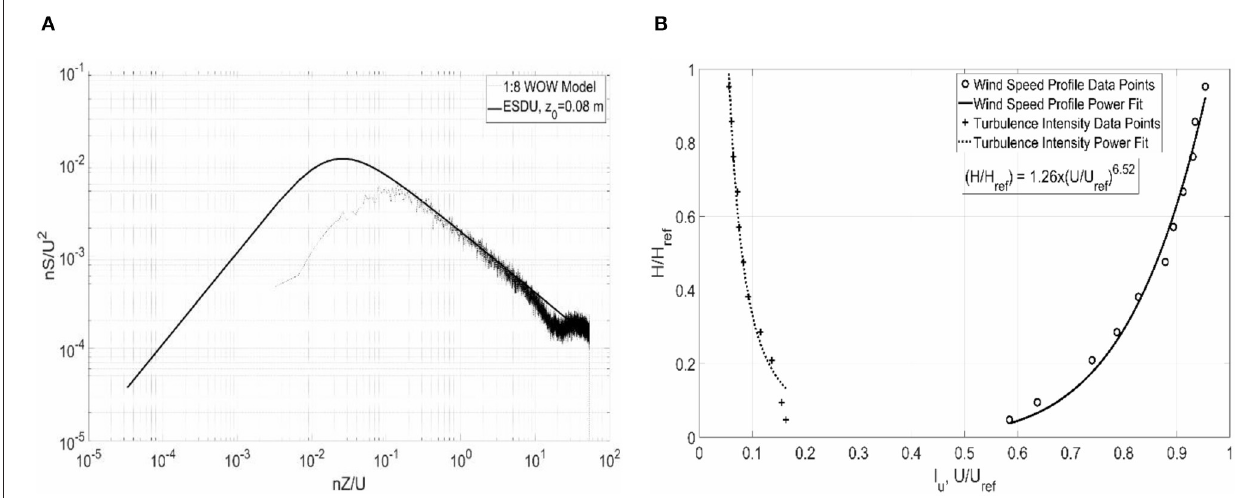
FIGURE 6 | (A) Normalized power spectral density (PSD) of longitudinal turbulence fluctuations, and (B) Normalized mean wind speed profile at the WOW.